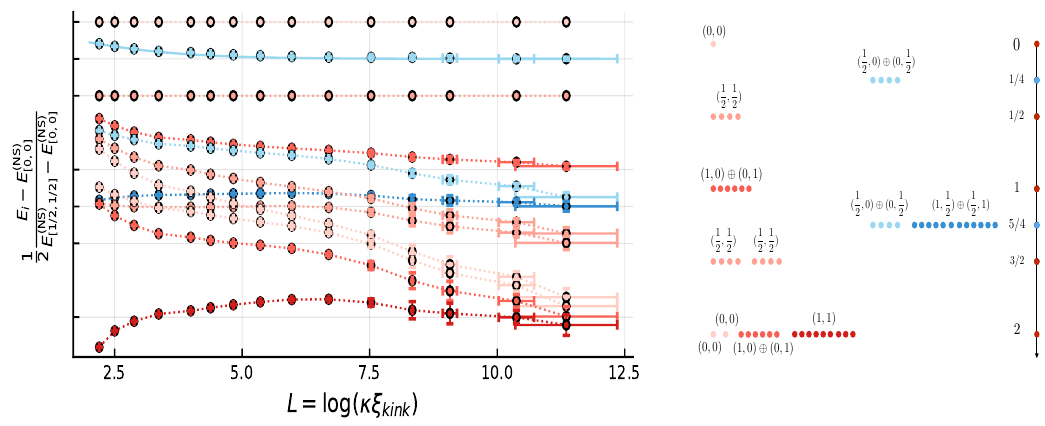
Figure 6 . On the right we show the CFT prediction for the gaps in the entanglement spectrum, for N = 2 and in the limit of large L . The vertical axis is rescaled by π/L . The left and right towers corresponds to NS and R boundary conditions, respectively. The plot in the left shows gaps in the entanglement spectrum, relative to the first gap in the NS sector, as extracted from the MPS representation of the ground state of our lattice model. Error bars are obtained in a similar fashion to those of the inverse correlation length (see figure 3). For sufficiently small couplings the ratios converge to those predicted in the right panel. The dotted lines are a guides for the eye. The full blue line is the prediction for the first gap in the Raymond sector from